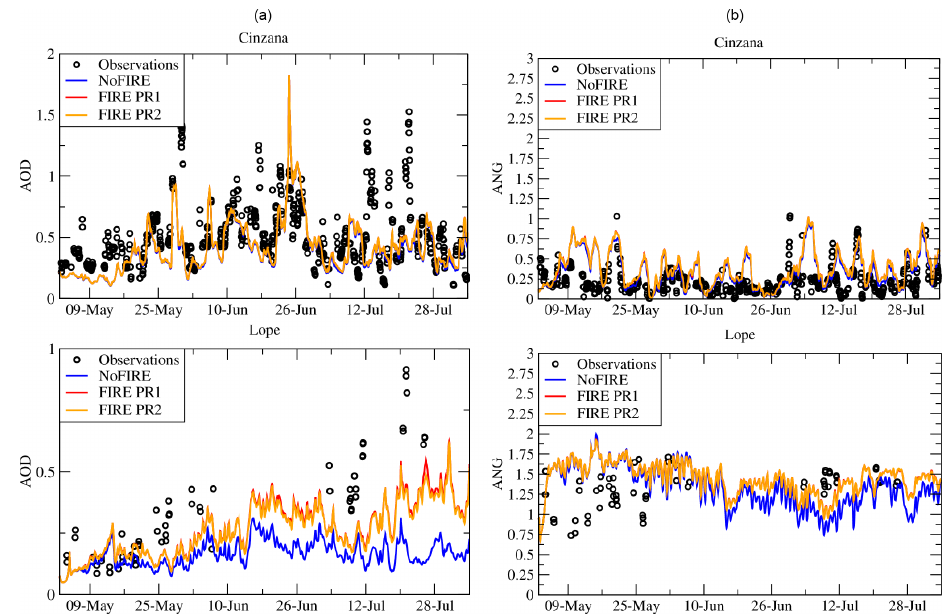
Figure 6. Comparison of AERONET measurements and model results for AOD (a) and the Ångström exponent (b) . Time series are presented for the Cinzana and Lope stations and for the whole modelled